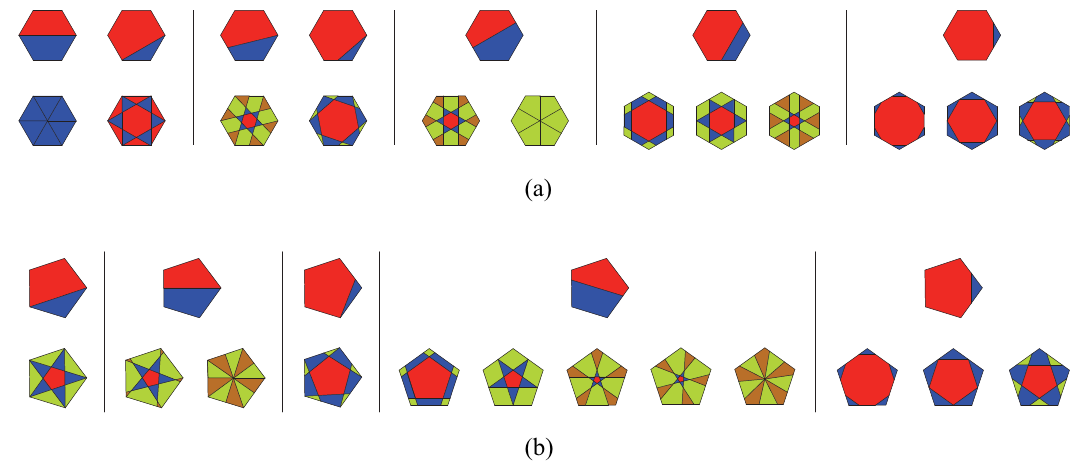
Figure 10. (a) Cutting a hexagon with 1 (d 1 upper row) or 6 knives (d 6 lower row). (b) Cutting a pentagon with 1 (d 1 upper row) or 5 knives (d 5 lower row).